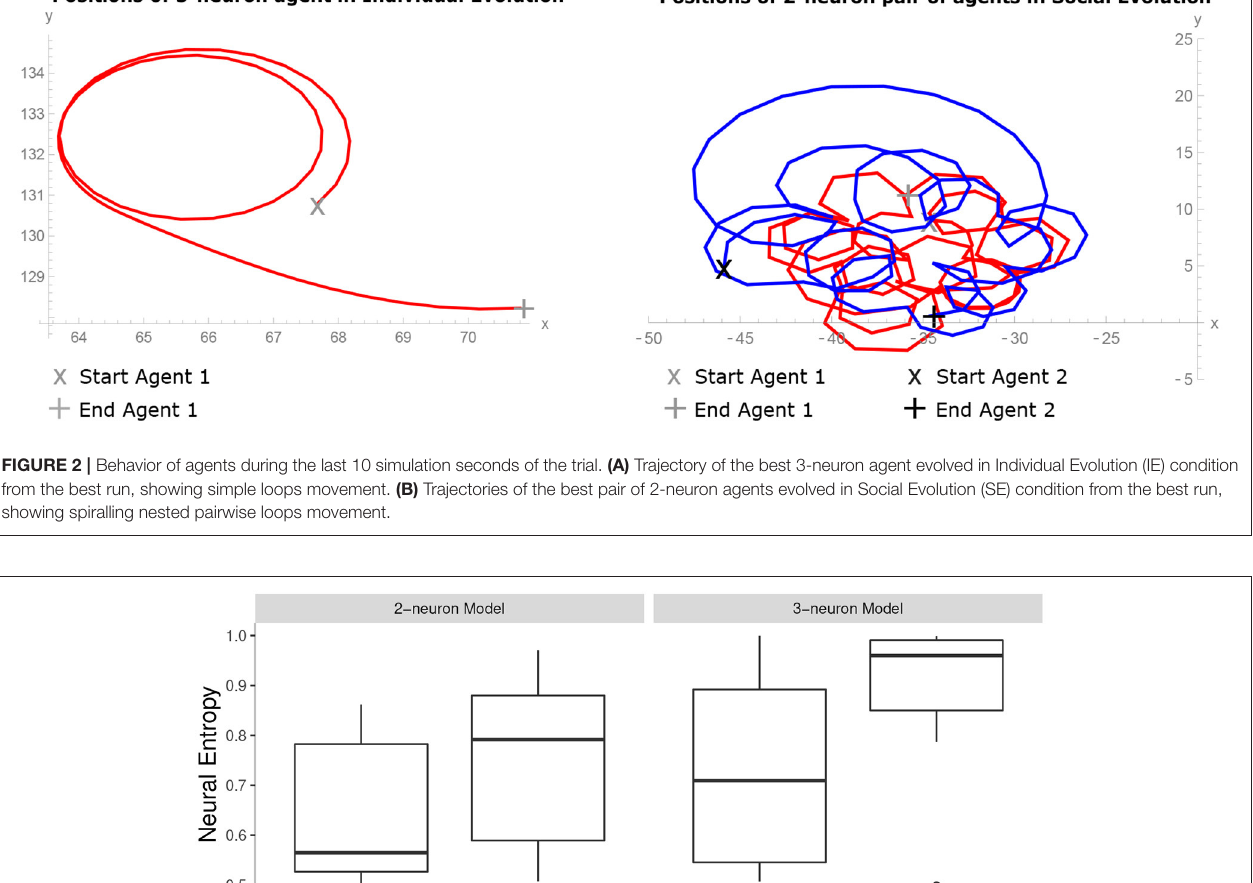
F (1, 36) = 4.62, p < 0.05 but no significant interaction